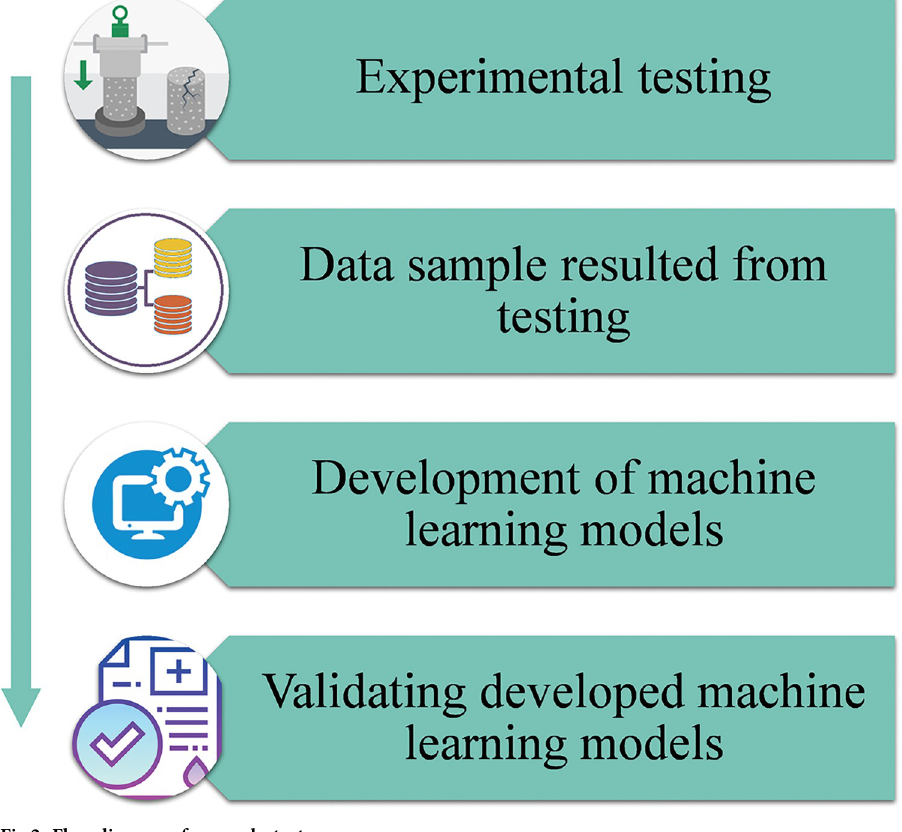
Fig 2. Flow diagram of research